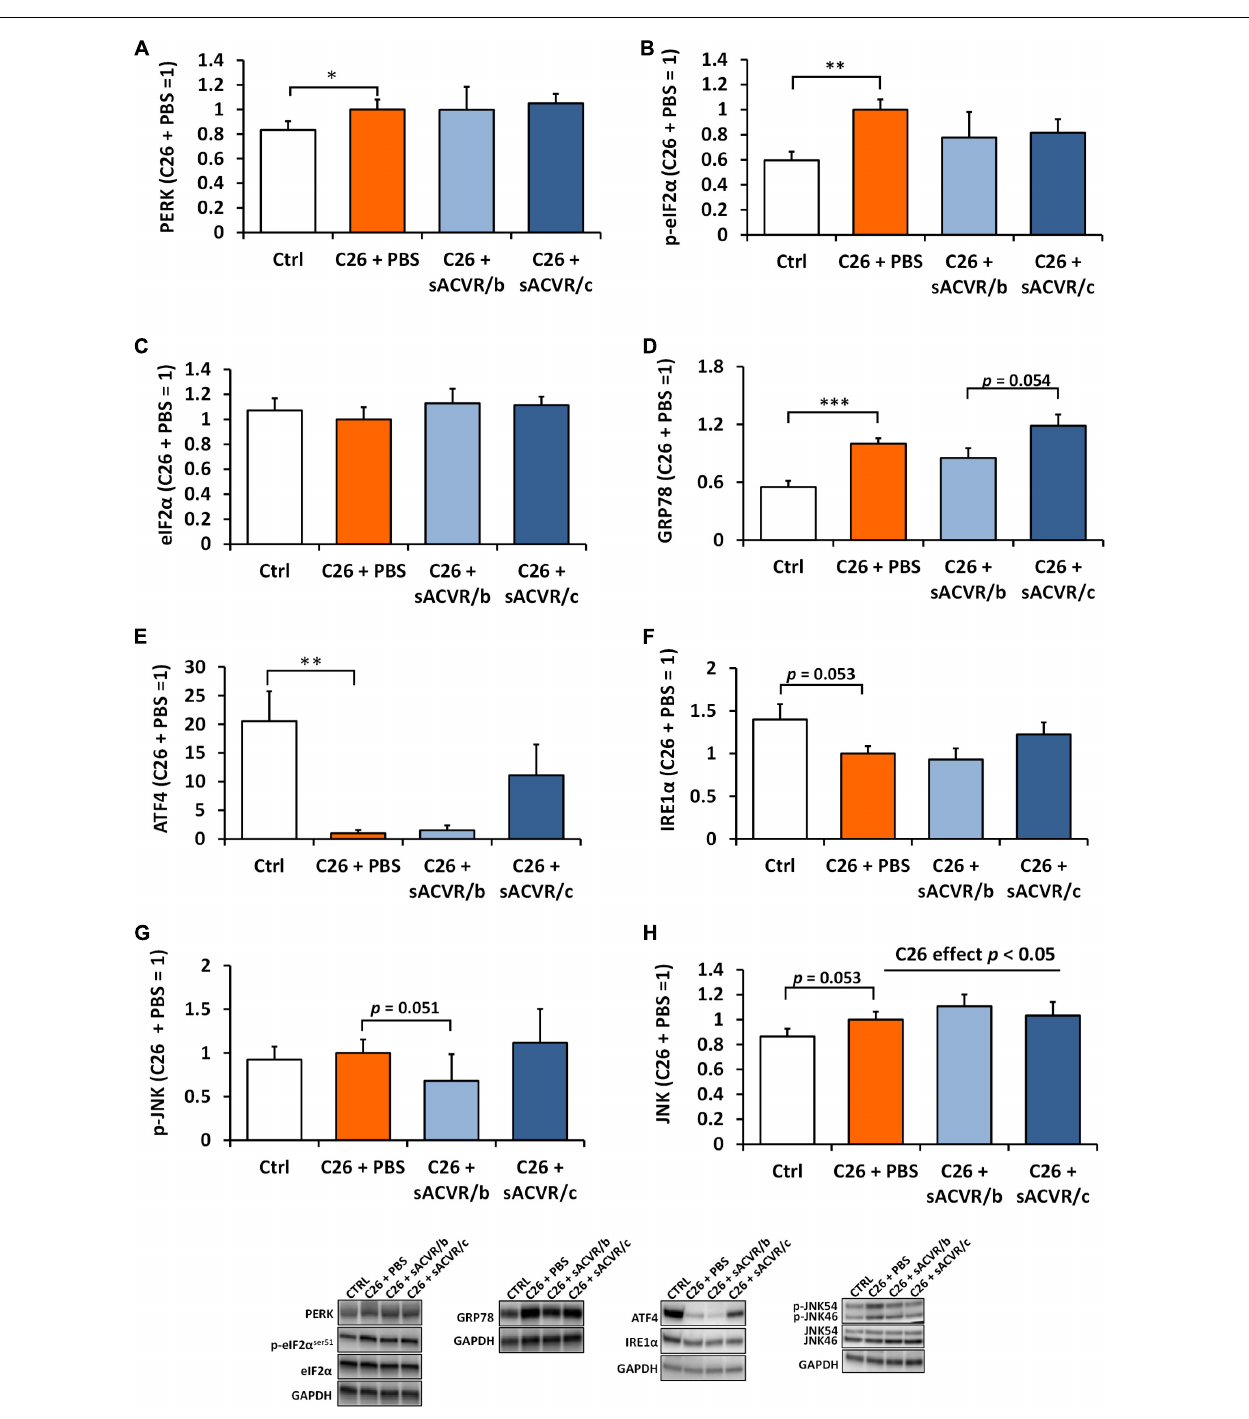
FIGURE 7 | Unfolded protein response (UPR) markers in the liver of C26 tumor-bearing mice. (A) PERK protein, (B) p-eIF2 α ser51 , (C) eIF2 α , (D) GRP78 protein, (E) ATF4 protein, (F) IRE1 α protein, (G) mean of p-JNK46 and p-JNK54, and (H) mean of total JNK46 and JNK54 protein. CTRL, vehicle-treated (PBS) healthy control mice, n = 9. C26 + PBS = C26 tumor-bearing mice administered with a vehicle (PBS), n = 7. C26 + sACVR/b = C26 tumor-bearing mice administered with sACVR before the tumor formation and replaced by a vehicle (PBS) after the tumor formation, n = 7. C26 + sACVR/c = C26 tumor-bearing mice continuously administered with sACVR throughout the experiment, n = 8. The symbol ∗ depicts statistical significance p < 0.05, the symbol ∗∗ depicts statistical significance p < 0.01 and the symbol ∗∗∗ depicts statistical significance p < 0.001. For the C26 effect, tumor-bearing groups were pooled. Data is expressed as means ± SE. Representative blots were cropped from the original blot images ( Supplementary Figures 11 , 12 ). Representative blots with same IDs and analyzed in the same run are aligned on top of each other and share the same representative control blot (GAPDH).